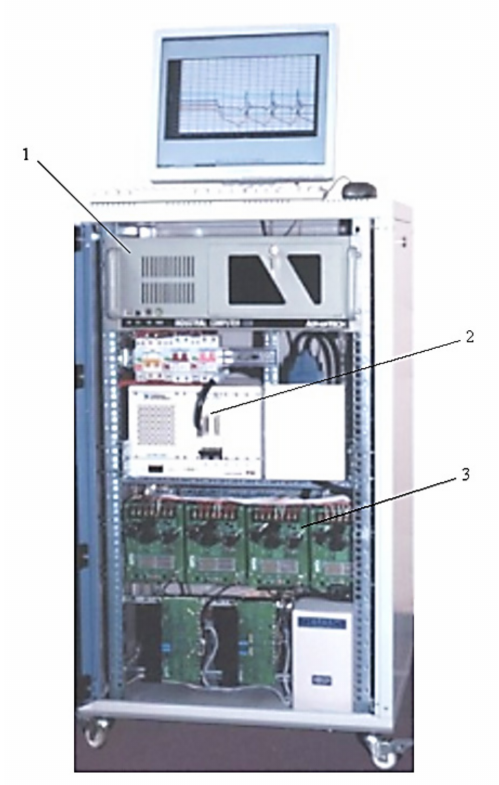
Figure 3. Image of the diagnosis complex used: 1—industrial computer; 2—DAC/ADC cards; 3—matching